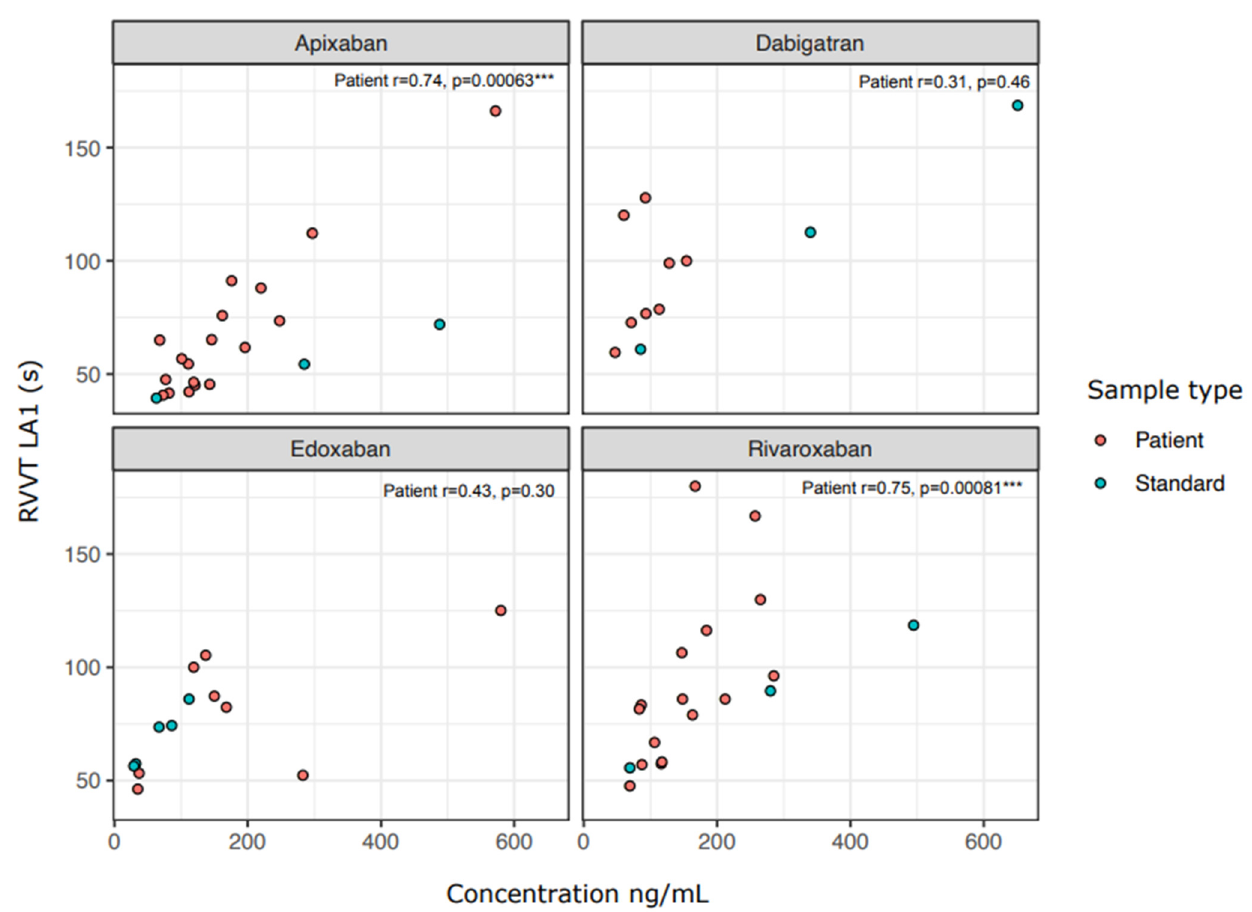
Figure 2. Lupus anticoagulant RVVT test screening assay results correlate with DOAC concentration. Results for the RVVT-based LA1 assay are shown prior treatment with DOAC-Stop™ or DOAC Filter ® . Correlations were calculated using Spearman correlation and the p -value and Spearman rho are shown in the panels. Abbreviations: api, apixaban; dabi, dabigatran; edo, edoxaban; riva, rivaroxaban; conc, concentration as ng/mL. Asterisks: ***: p < 0.001.